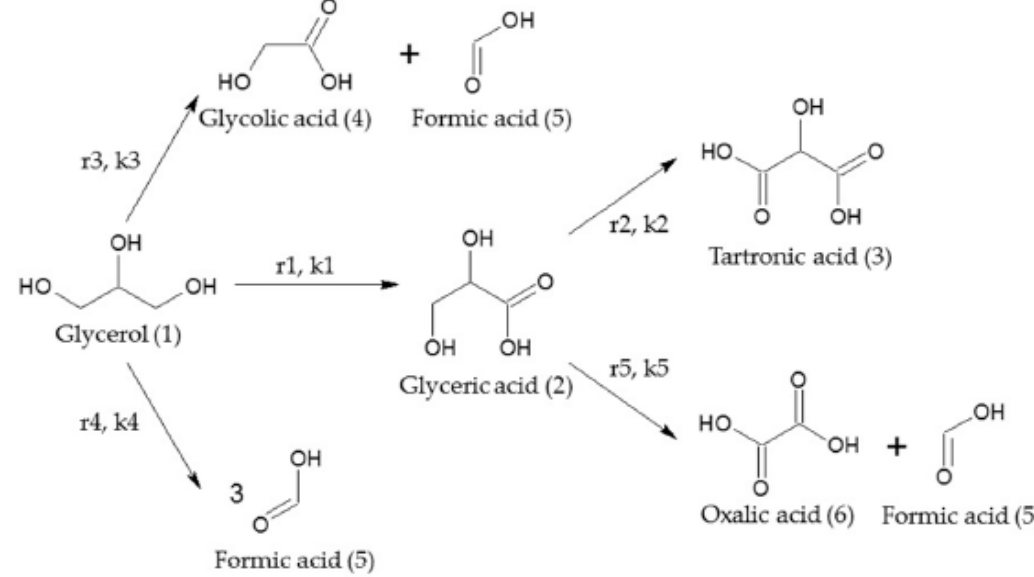
Figure 21. Proposed reaction pathways of glycerol oxidation. Reprinted with permission from reference [153]. Copyright 2017 Wiley.